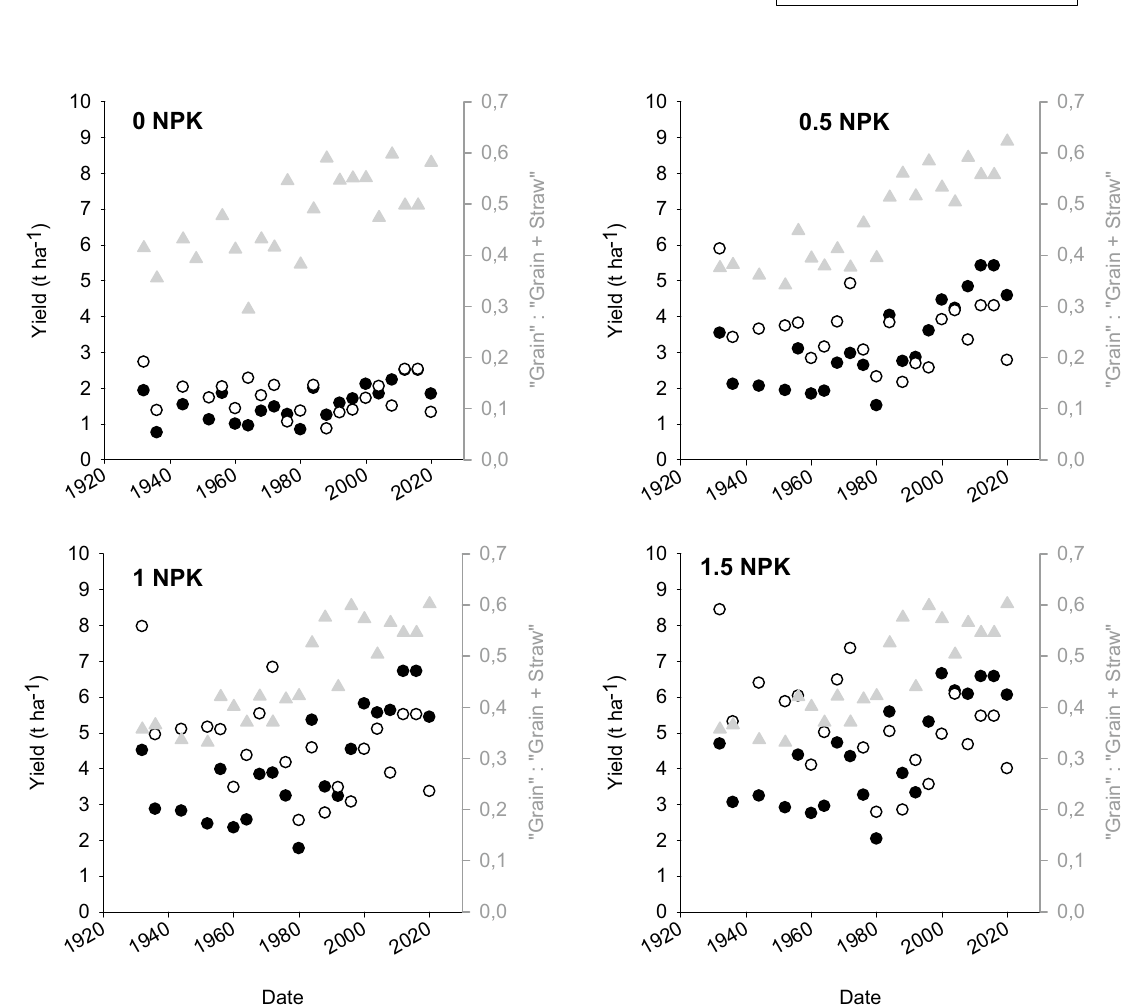
Figure 1. Grain and straw yields for winter wheat obtained in Lermarken during 1932 to 2020 on unfertilised plots (0) and plots treated with different rates of mineral fertilizers (NPK). The ratio between grain and grain + straw is shown on right y axis. Straw includes chaff but not stubbles. Treatmen t